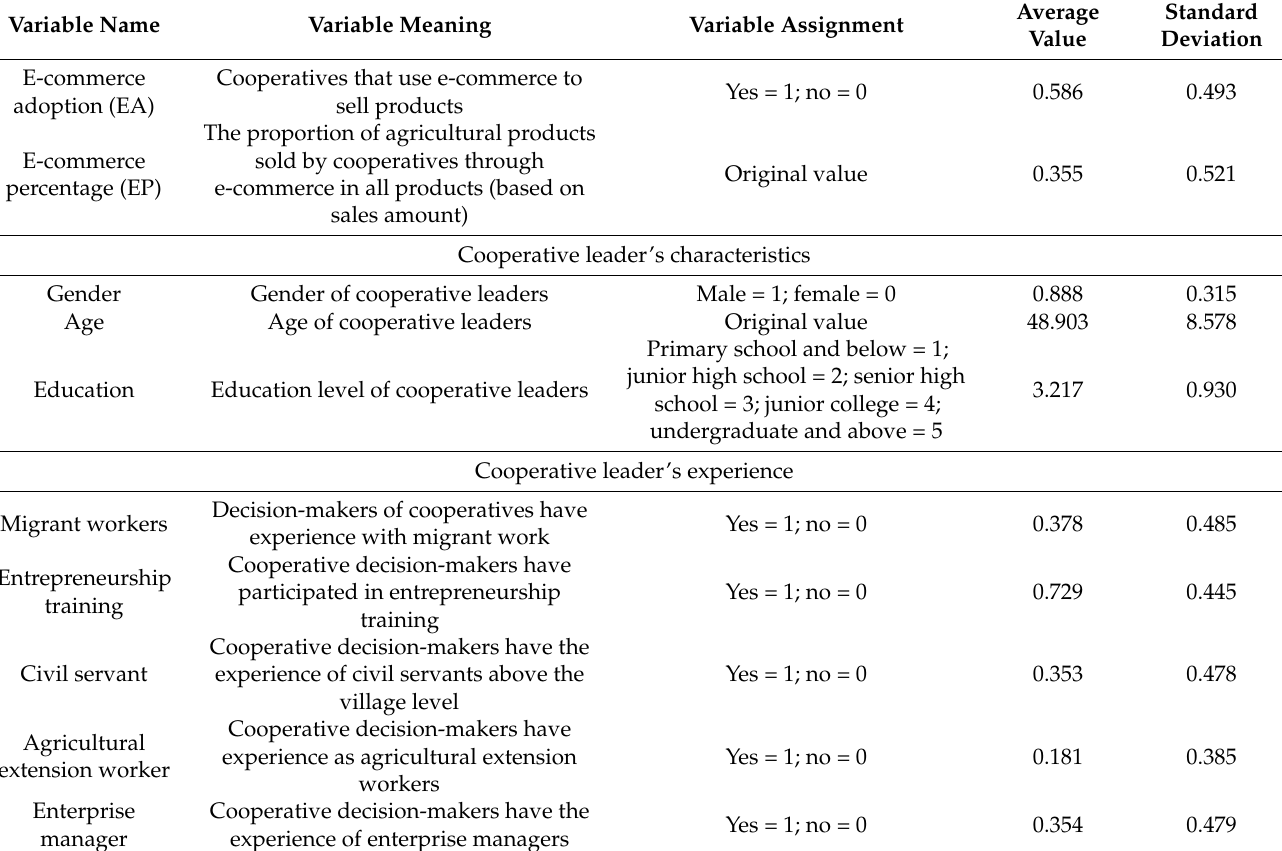
Table 2. Summary and description of control